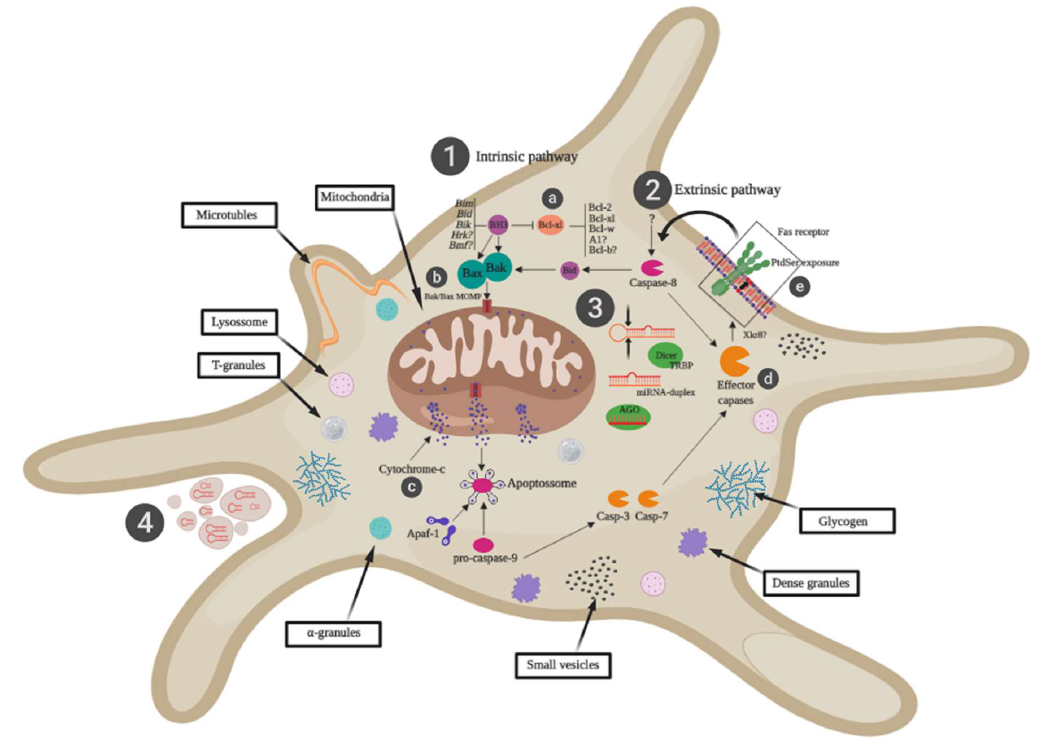
Figure 2. The role of miRNAs in platelet apoptosis.